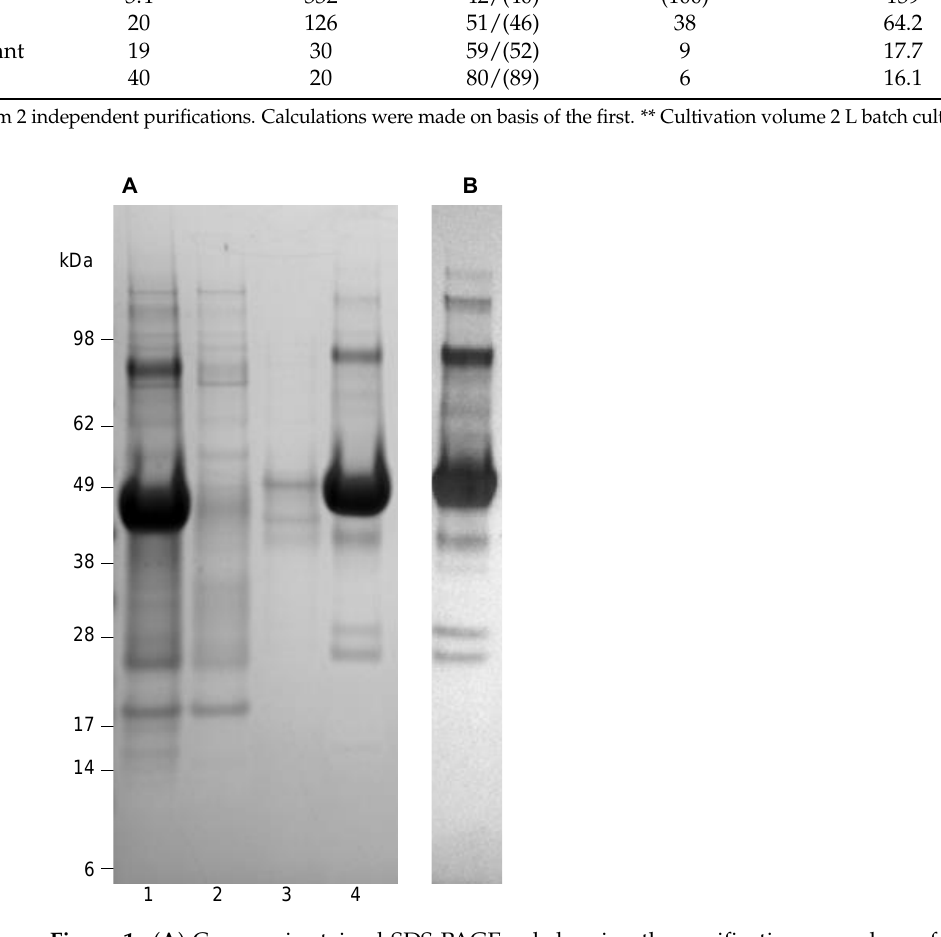
Figure 1. ( A ) Coomassie-stained SDS-PAGE gel showing the purification procedure of USUV E protein from E. coli , starting with isolated inclusion bodies. Lane 1, inclusion bodies solubilized in 20 mM Tris, 8.0 M urea, pH 8.0, prior to application on the Ni-IMAC column; lane 2, Flow-through; lane 3, wash with 20 mM Tris, 8.0 M urea pH 8.0, 10 mM imidazole; lane 4, elution with 20 mM Tris, 8.0 M urea pH 8.0, 100 mM imidazole. ( B ) Western blot analysis of the purified USUV